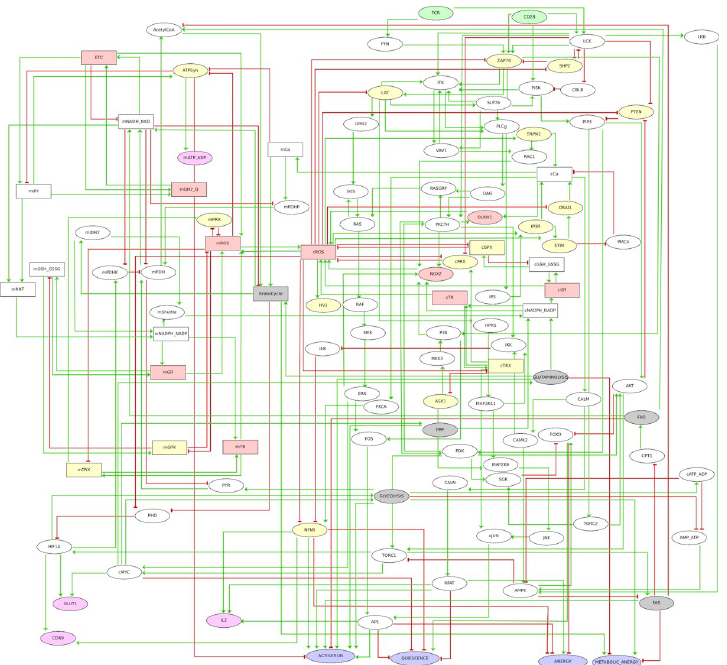
Fig 3. Logical regulatory graph of the TCR-REDOX metabolism model. The model was designed to study the interaction between the redox state and cellular metabolism and its influence on the activation of human CD8 + T lymphocytes. The nodes can be divided into three main categories: mitochondrial nodes (upper left), TCR signaling nodes (upper right), cytosol component nodes (center right and bottom right). A color code further denotes the type of node: green (input), gray (metabolic pathway), pink (ROS or ROS source), yellow (redox sensitive), magenta (output) and purple (phenotype). Elliptical shapes denote Boolean nodes (taking the values 0 or 1), while rectangular shapes denote multilevel (ternary) nodes (taking the values 0, 1 or 2). The arcs connecting the nodes represent positive (green) or negative (red) regulatory influences. In the case of multilevel regulatory nodes, the thresholds required for the activation of the different target nodes can be found in the model available online (http://ginsim.org/node/229).